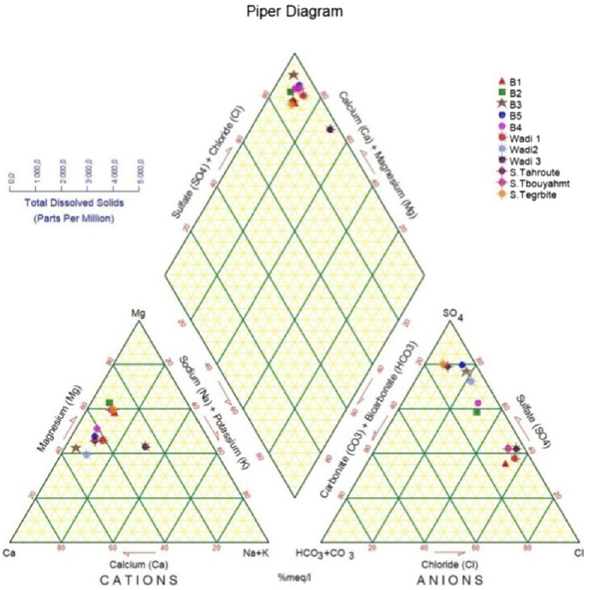
Fig. 4 Triangular piper diagram for the study area